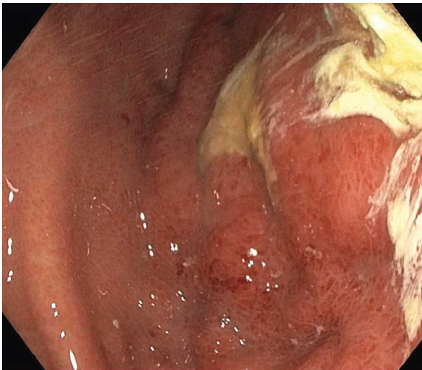
Figure 2: Upper endoscopy showing large nonobstructing non- bleeding gastric deep ulcerations with exudate